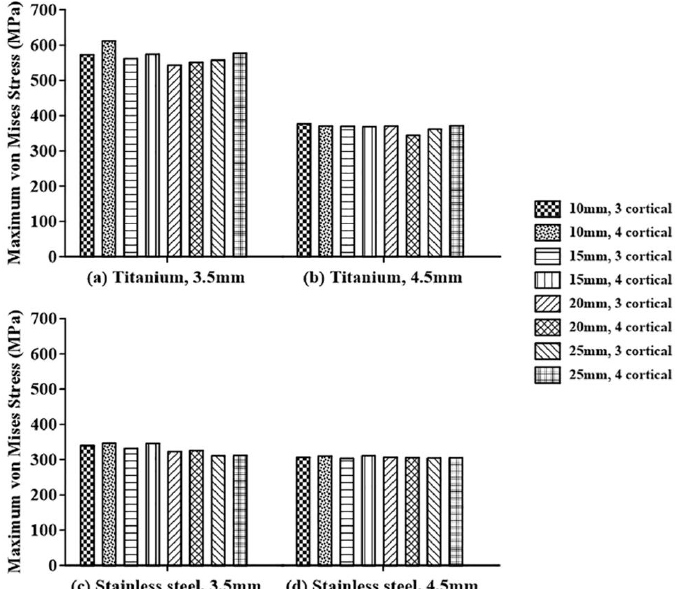
Figure 8. Analysis of the maximum von Mises stresses of the syndesmotic screw in terms of the number of penetrated cortical bones for: ( a ) titanium screw with a diameter of 3.5 mm, ( b ) titanium screw with a diameter of 4.5 mm, ( c ) stainless steel screw with a diameter of 3.5 mm, and ( d ) stainless steel screw with a diameter of 4.5 mm.